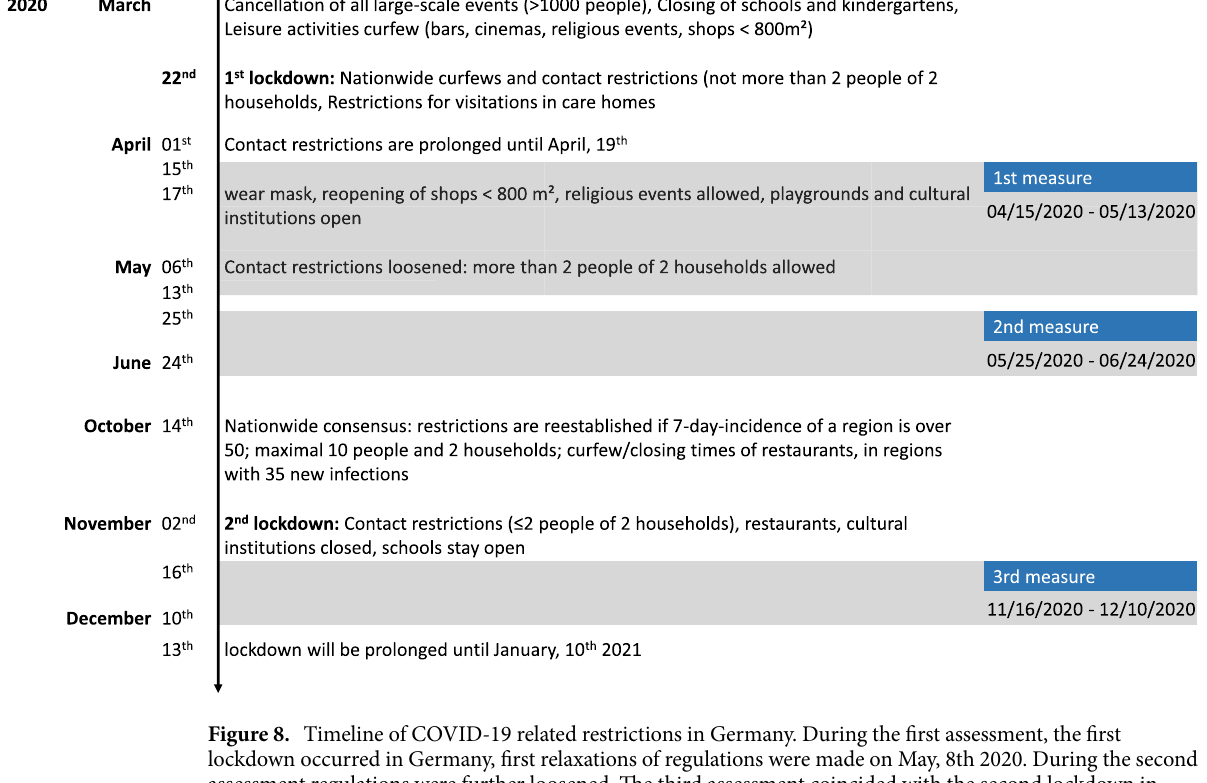
Figure 8. Timeline of COVID-19 related restrictions in Germany. During the first assessment, the first lockdown occurred in Germany, first relaxations of regulations were made on May, 8th 2020. During the second assessment regulations were further loosened. The third assessment coincided with the second lockdown in